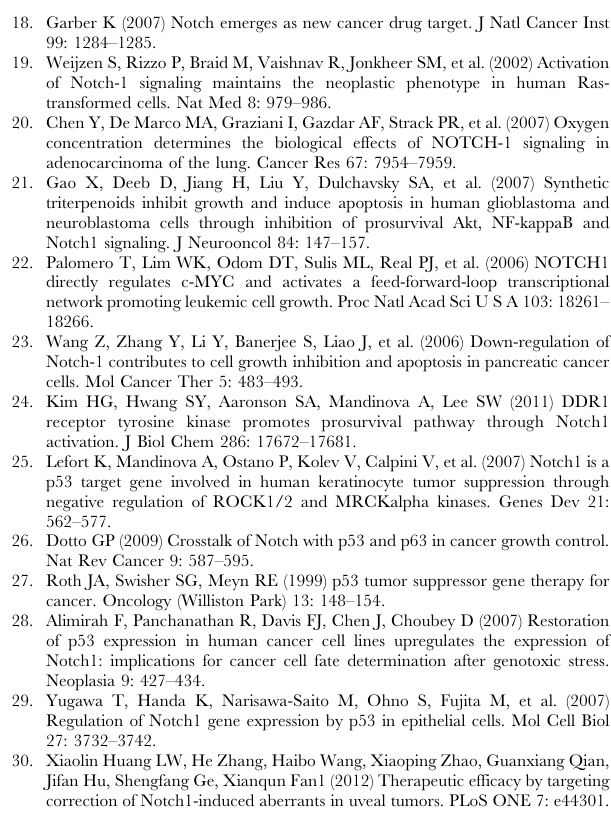
means 6 SD of three independent experiments. *p , 0.05, # p , 0.01 as compared with negative control. (TIF) Figure S3 Cell proliferation of normal cervical kerati- nocytes cells following the combined treatment of Notch1-siRNA and H101. Cell proliferation was measured by MTT assays 72 hours after co-treatment of Notch1-siRNA (100 nmol/l) and 48 hours after H101 infection (multiplicity of infection (MOI) = 100). All data are presented as means 6 SD of three independent experiments. (TIF) Figure S4 The activity of caspase-3 in Hela-S3 tumor cells. Cells were transfected with the Notch1-siRNA and H101 for 72 hours, and total protein was analyzed by the Caspase-3 Colorimertric Activity Assay Kit. (TIF) Figure S5 Expression of p21 in HeLa-S3 tumor cells. Cells were transfected with the Notch1-siRNA and H101 for 72 hours, and total protein was analyzed by Western blot with specific antibodies. (TIF) Method S1 The sphere